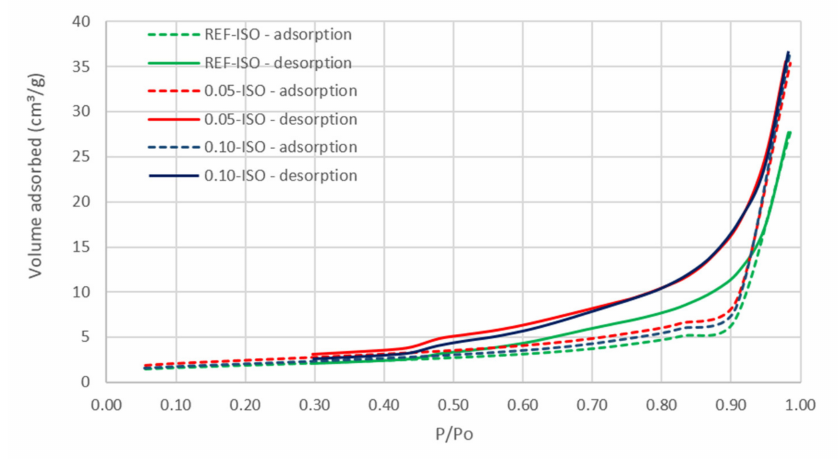
Figure 10. Isotherm curves of cement